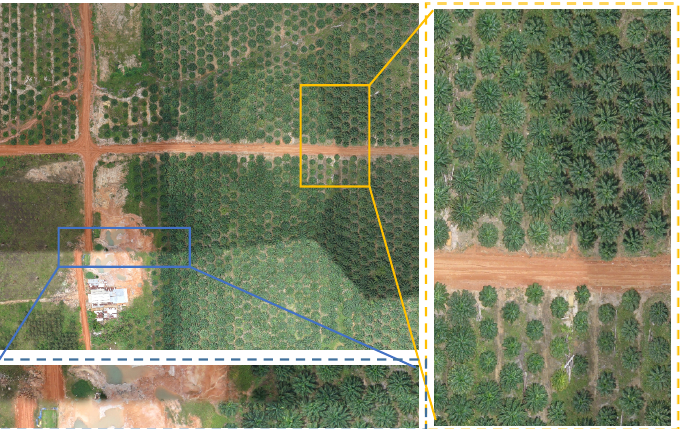
Figure 7. Discussion about the influence of fast-changing light condition and low overlapping rate for our proposed stitching method. The yellow box shows the stitching result in slight light changes condition. And the blue box displays the misalignment stitching result in low overlapping rate and fast-changing